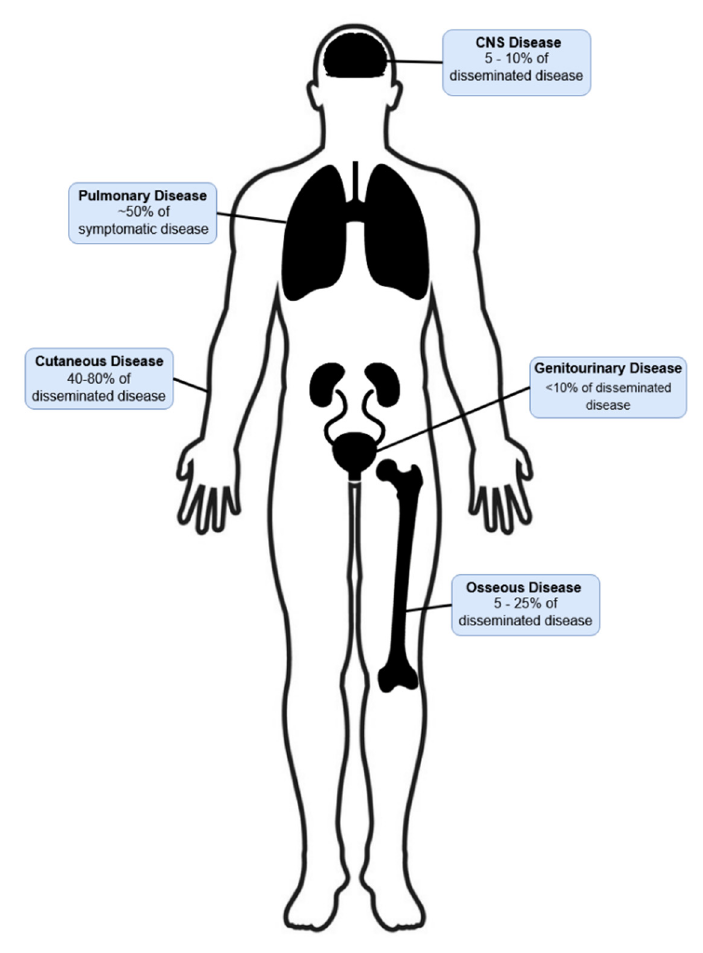
Figure 3. Sites of disseminated blastomycosis. CNS: central nervous system.